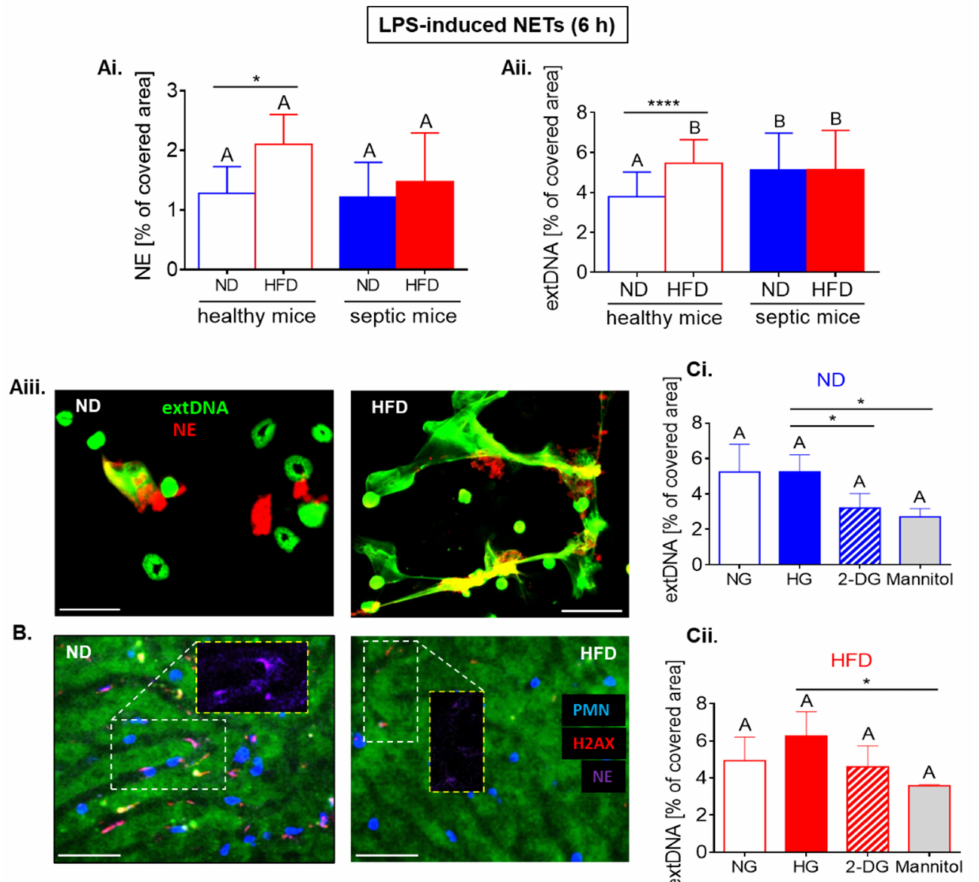
Figure 7. Long-term LPS-induced formation of neutrophil extracellular traps (NETs) by neutrophils of mice with obesity induced by high fat diet (HFD) and their lean controls (ND) either ex vivo or in vivo. Studies were performed on either healthy mice (not treated in any way; healthy mice) or with ongoing systemic inflammation/endotoxemia induced 24 h prior to analyses by injecting animals with 1 mg/kg body weight of lipopolysaccharide (LPS; septic mice). Ex vivo NET formation was evaluated 6 h after cell activation with lipopolysaccharide (LPS; ( Ai , Aii )). NET quantification: area [%] covered by neutrophil elastase (NE) ( A ) and extracellular DNA (extDNA) ( B ) Representative images from ex vivo studies: immunocytochemical counterstaining of neutrophil elastase (NE, red) along with extracellular DNA staining (extDNA, green). Scale bar indicates 25 µ m ( Aiii ). Additionally, in vivo NET formation in liver vasculature was estimated at 6 h of endotoxemia ( B ). On images neutrophil elastase (NE, violet) is visible lining along sinusoids (black ducts) which are localized in between autofluorescent hepatocytes (dim green). White dashed line denotes regions rich in neutrophil elastase (violet) and histone H2A.X (red). Areas are additionally shown in Cy5 channel (NE signal) only (yellow dashed line). Neutrophils are denoted in blue. Scale bar indicates 25 µ m ( B ). ( C ) In some ex vivo experiments, neutrophils were pretreated prior to LPS stimulation with 2-deoxy-D-glucose (2-DG; Ci for ND neutrophils, Cii for HFD cells). Additionally, some neutrophils were cultured in HBSS supplemented with high glucose (22 mM, HG) or normal glucose (5.5 mM, NG), or mannitol as osmolarity control ( Ci , Cii ). Asterisks indicate significant differences between groups upon unpaired two-tailed Student’s t -test (* p ≤ 0.05, **** p ≤ 0.0001). Results of one-way ANOVA (post hoc Bonferroni): any two means that do not share same letter are significantly different. Data are shown as mean ± s.d.; n ≥ 3 per